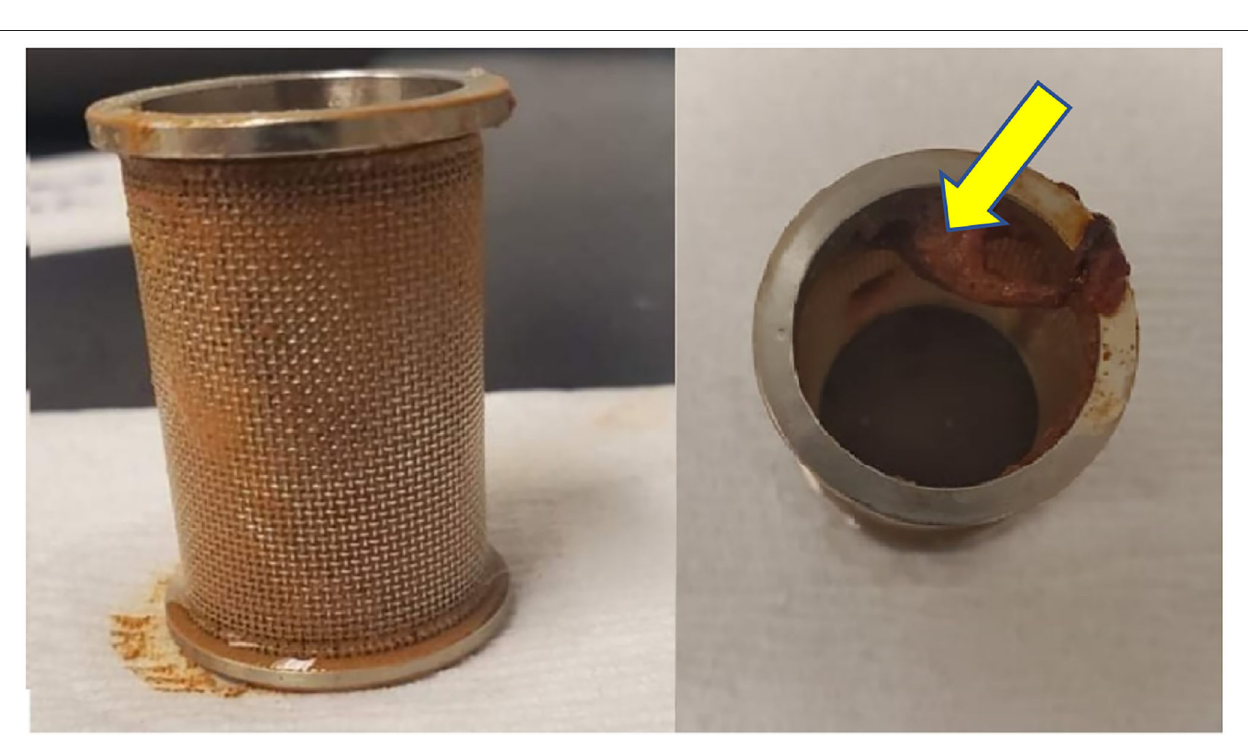
FIGURE 3 | GSE capsule residues within the dissolution basket after 2h dissolution in 0.1N hydrochloric acid (pH 1.2) (as indicated by